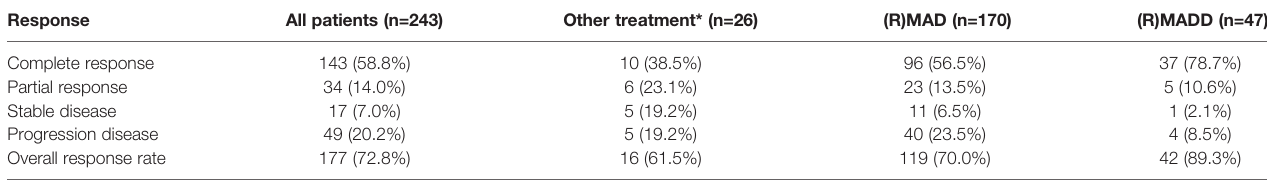
TABLE 3 | Outcome of fi rst-line treatment.